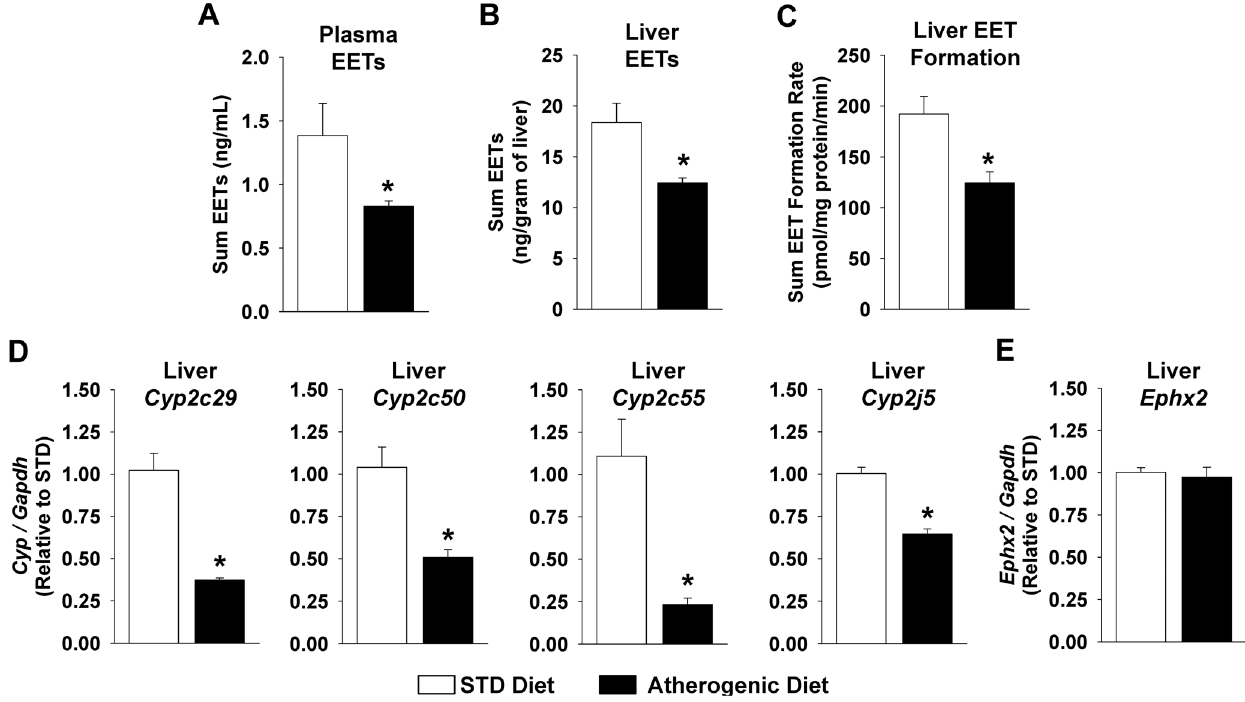
Figure 3. Atherogenic diet administration suppresses the CYP epoxygenase pathway. (A) Plasma sum EET levels and (B) liver sum EET levels were significantly lower in mice administered the atherogenic diet compared to mice administered the STD diet (n=4–6 per group). (C) The EET formation rate in the presence of saturating arachidonic acid concentrations was also suppressed in liver microsomes isolated from mice administered the atherogenic diet compared to mice administered the STD chow diet (n=8 per group). (D) Liver Cyp2c29 , Cyp2c50 , Cyp2c55 , and Cyp2j5 mRNA levels were significantly suppressed but (E) Ephx2 mRNA levels were not significantly different (STD diet: n=6, atherogenic diet n=5). *P , 0.05 vs. STD diet